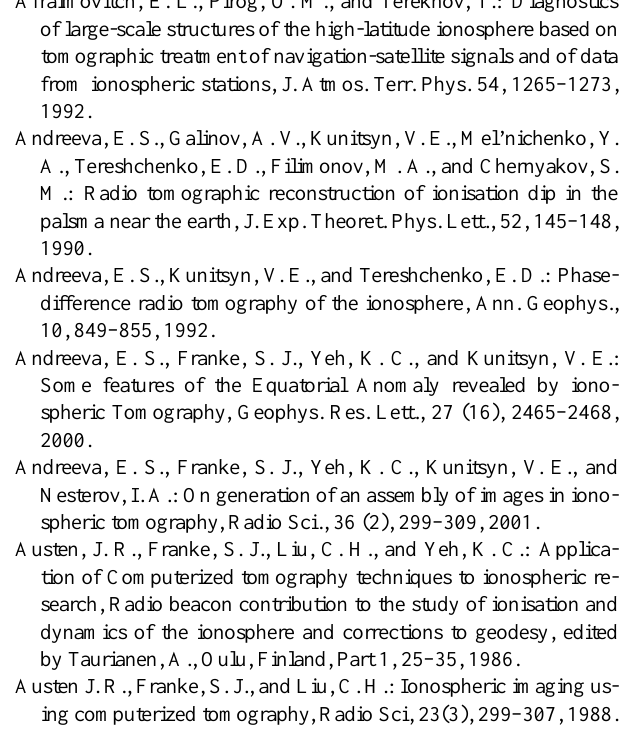
day (26 February 2003) and ( b ) disturbed day (14 July 2003) (elec-